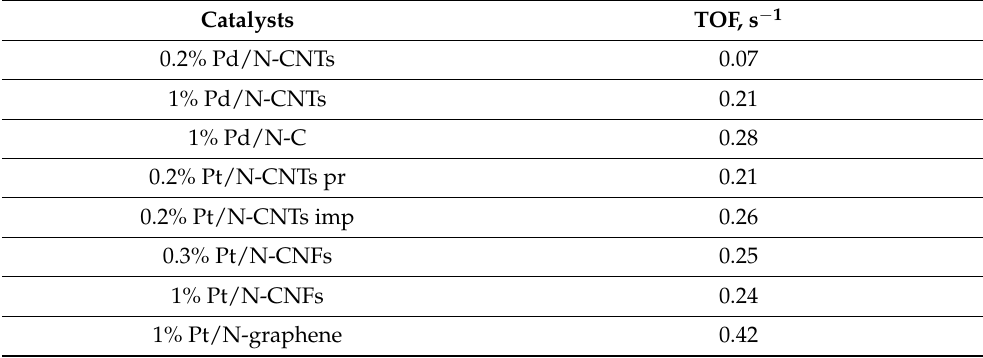
Table 4. TOFs for the formic acid decomposition reaction at 125 ◦ C over Pd and Pt catalysts